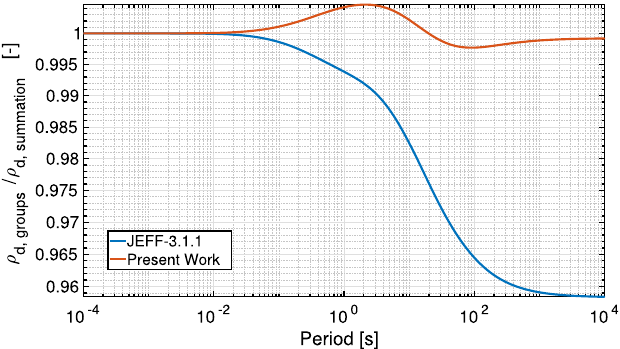
Fig. 3. Effect of the abundances on positive